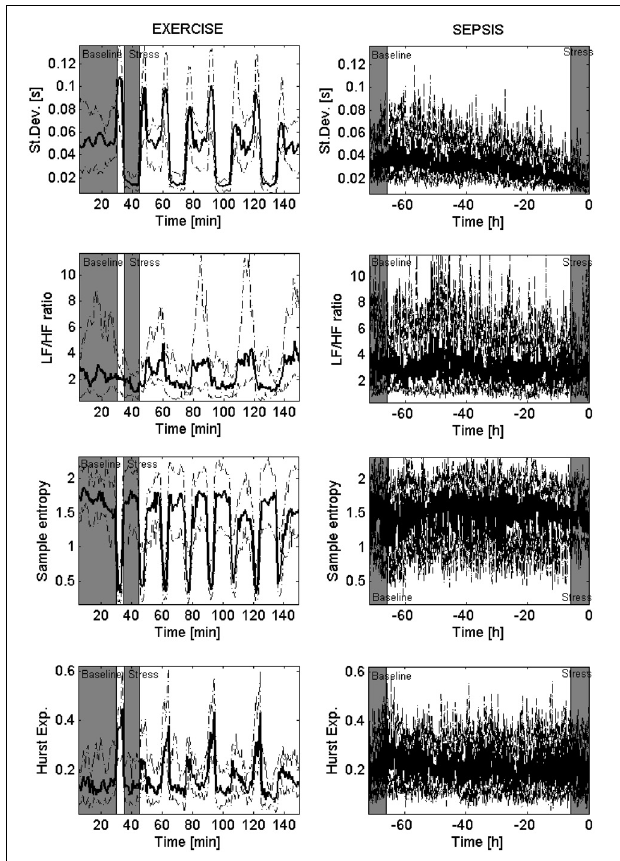
FIGURE 2 | Population trends in physiological dimensions of variability. These eight panels show the population trends of four measures of variability, hypothetically linked to separate physiological dimensions. From the top, each row presents: standard deviation, LF/HF ratio (computed through the Lomb–Scargle periodogram), sample entropy, and Hurst exponent (computed through Scaled windowed variance). The columns depict the median trend across all the subjects (bold solid line) and its 95% confidence intervals (dashed line) for the EXERCISE dataset (left) and the SEPSIS dataset (right). In gray are highlighted the areas we referred to as “baseline” and